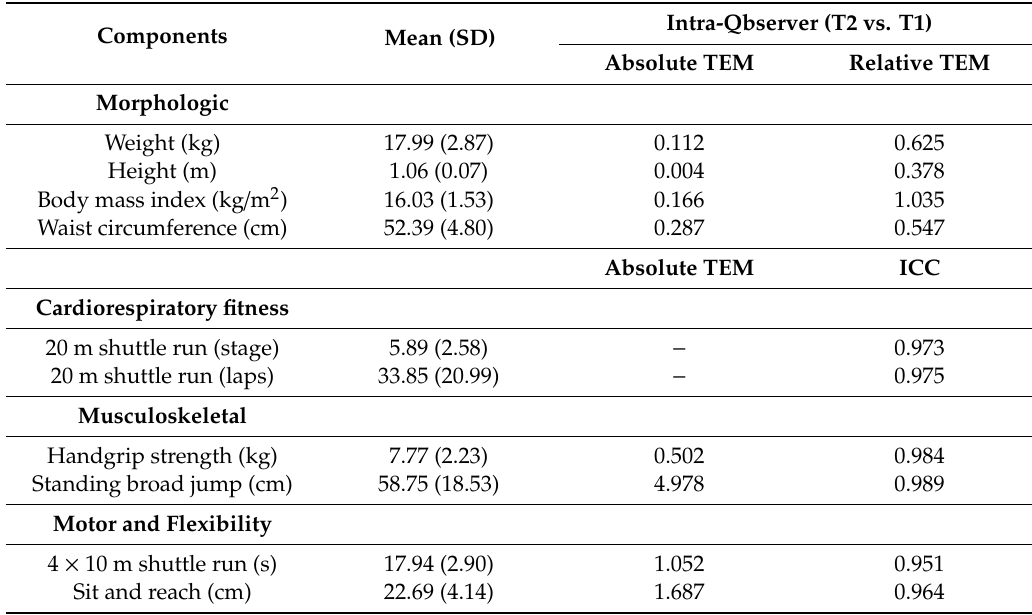
Table 3. Intra-observer TEM, relative TEM (%), and intra-class coe ffi cient for fitness component assessments of “Fuprecol kids”